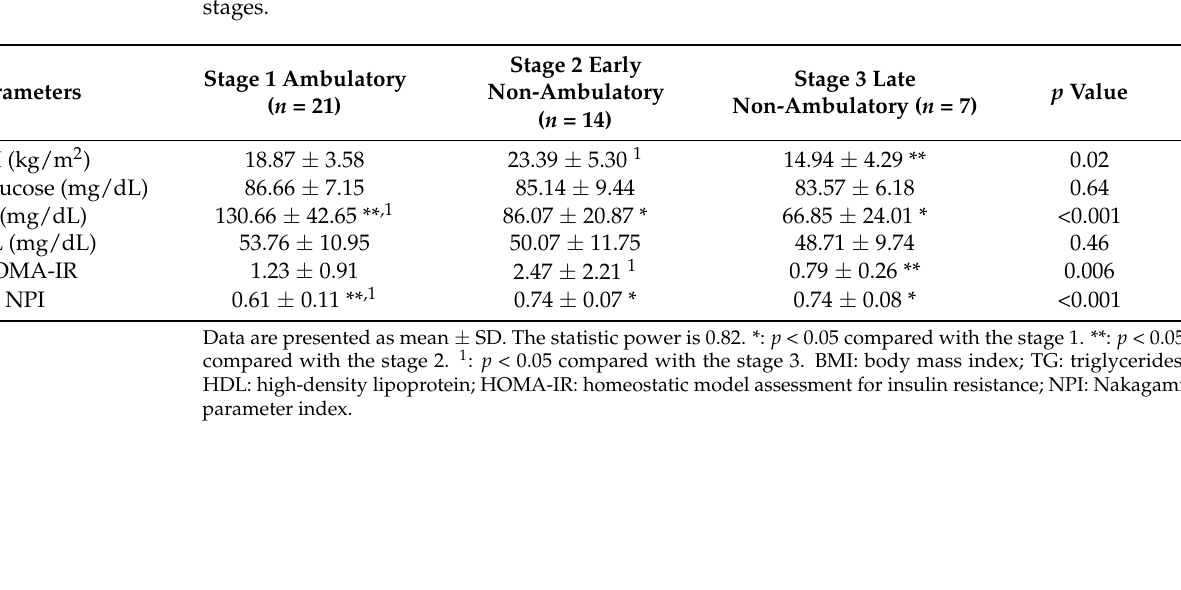
Table 2. Anthropometric and biochemical parameters of the DMD patients at different ambulatory